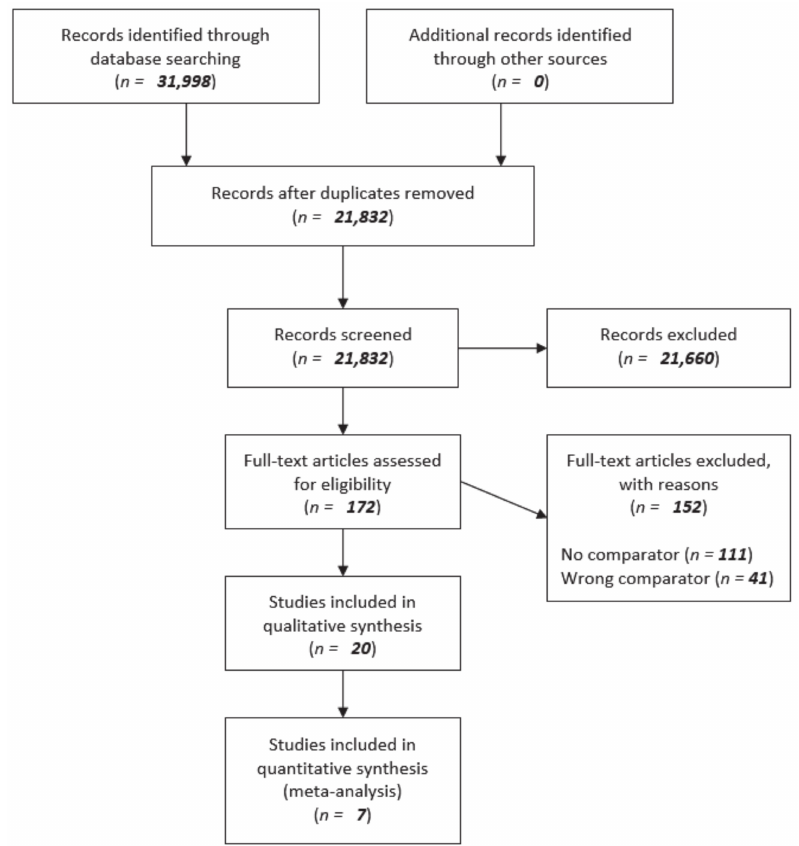
Figure 1. Flow diagram of systematic search and selection according to PRISMA